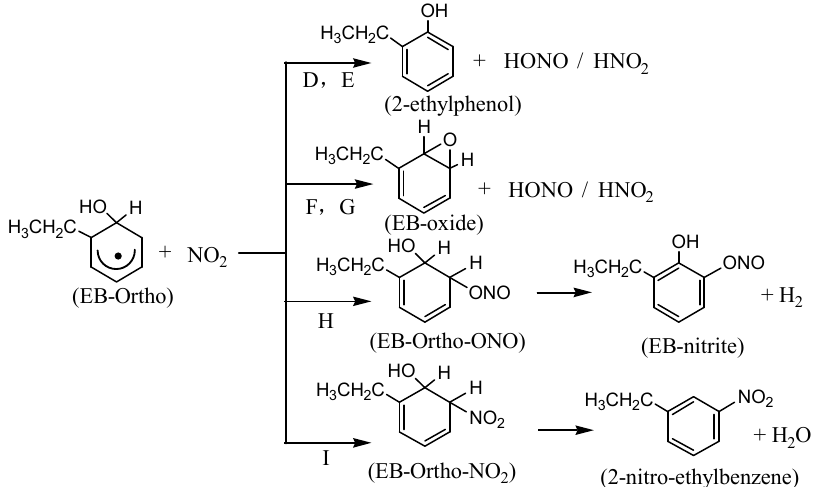
Figure 2. Six postulated channels of EB-Ortho with NO 2 [18].